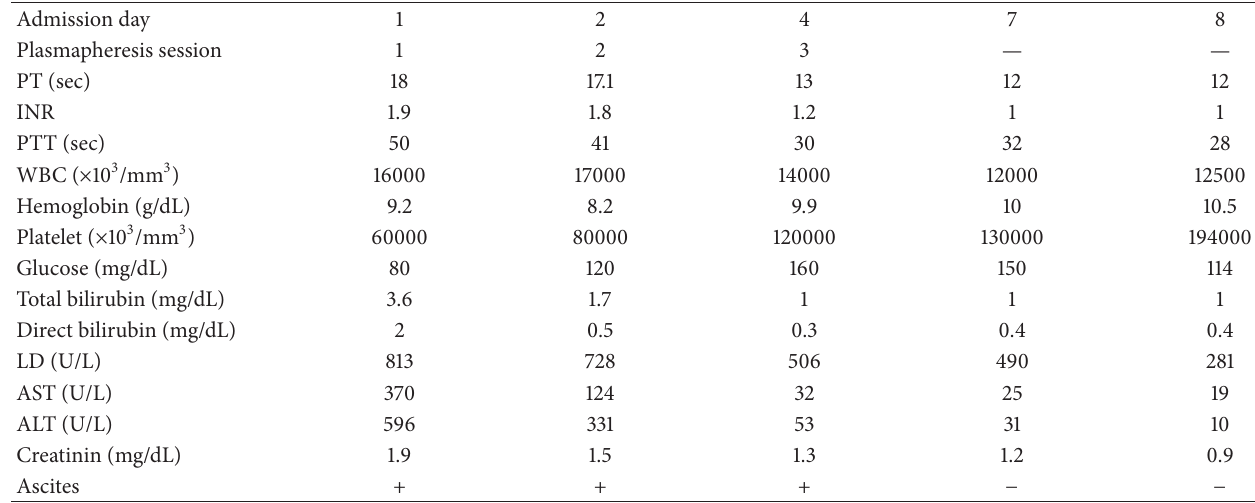
Table 3: Laboratory data of the third